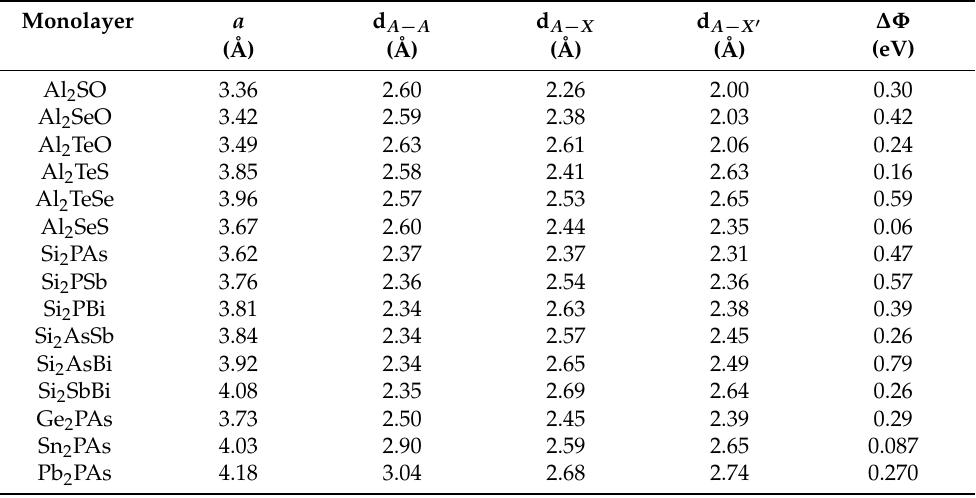
Table 1. The lattice constant (a), A-A (d A − A ), A-X (d A − X ), A-X’d A − X (cid:48) bond lengths and the work function difference ∆Φ of 15 different structures of A 2 XX’ monolayers.